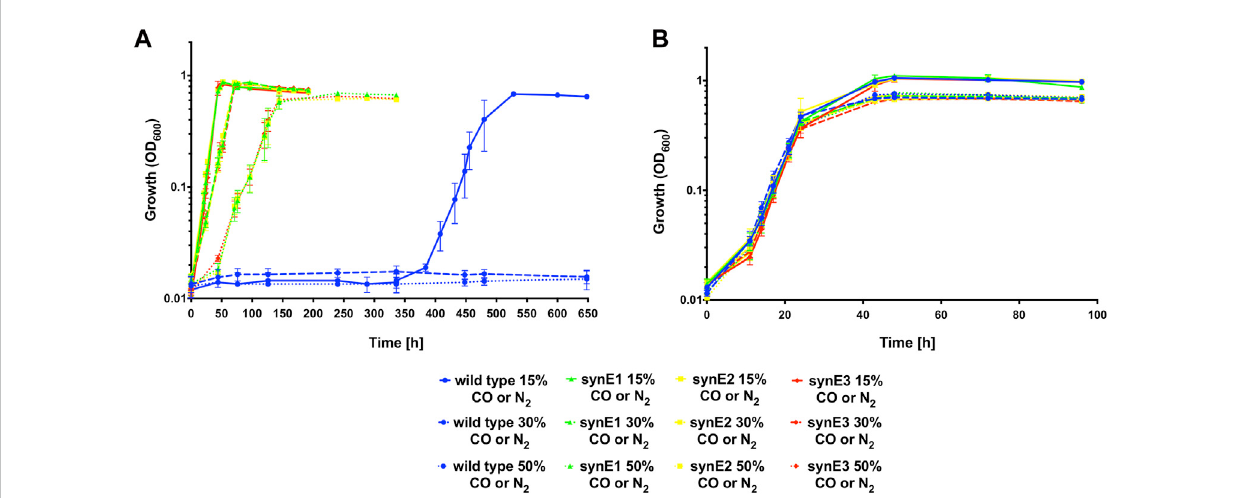
FIGURE 7 Autotrophic growth of C. necator synE isolates compared to the H16 wild type under syngas-like atmospheres with increasing CO concentrations. Culturesweregrownat30 ° Cin25 mLMMcontainedin250 mLserumbottlesundera2.4 baratmof (A) 15%CO/65%H 2 /10%CO 2 /10%air(v/v)(fulllines), or30%CO/50%H 2 /10%CO 2 /10%air(v/v)(dashedlines),or50%CO/30%H 2 /10%CO 2 /10%air(v/v)(dottedlines),and (B) 15%N 2 /65%H 2 /10%CO 2 /10%air (v/v) (full lines), or 30% N 2 /50% H 2 /10% CO 2 /10% air (v/v) (dashed lines), or 50% N 2 /30% H 2 /10% CO 2 /10% air (v/v) (dotted lines). Blue circles, wild type; green triangles, synE1; yellow squares, synE2; red circles, synE3. Error bars represent the standard deviation of the mean for two independent replicates.